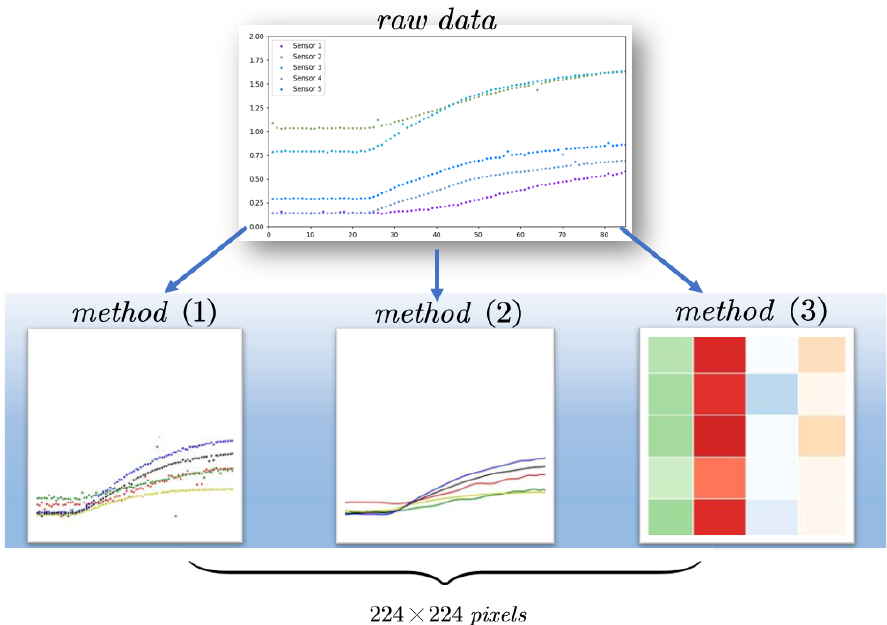
Figure 4. Three methods were proposed to convert the raw text data into image data: (1) Scatter plot; (2) Fitted curve plot; (3) Heat map. (2) Fitted curve plot; (3) Heat